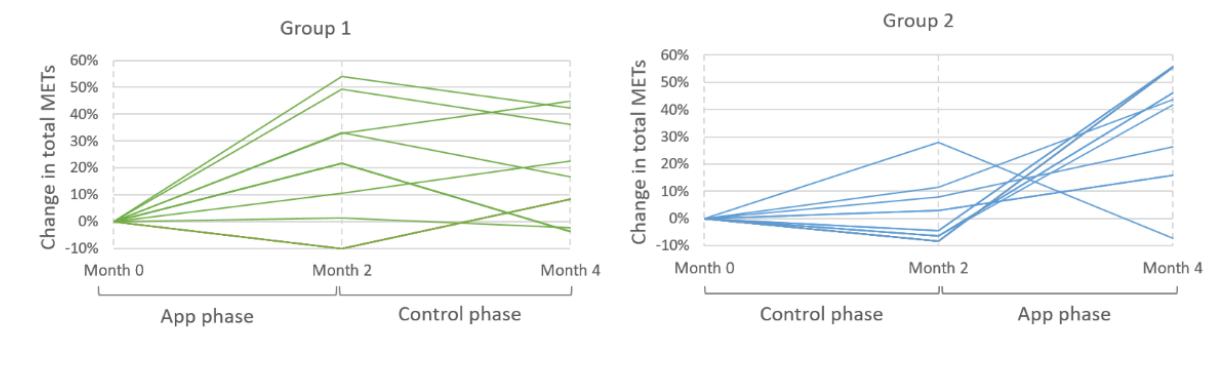
Figure 11. Graphs showing increase or decrease in total Metabolic Equivalents Of Task across different phases of the study for both groups of patients as collected from the International Physical Activity Questionnaire. MET: Metabolic Equivalents of